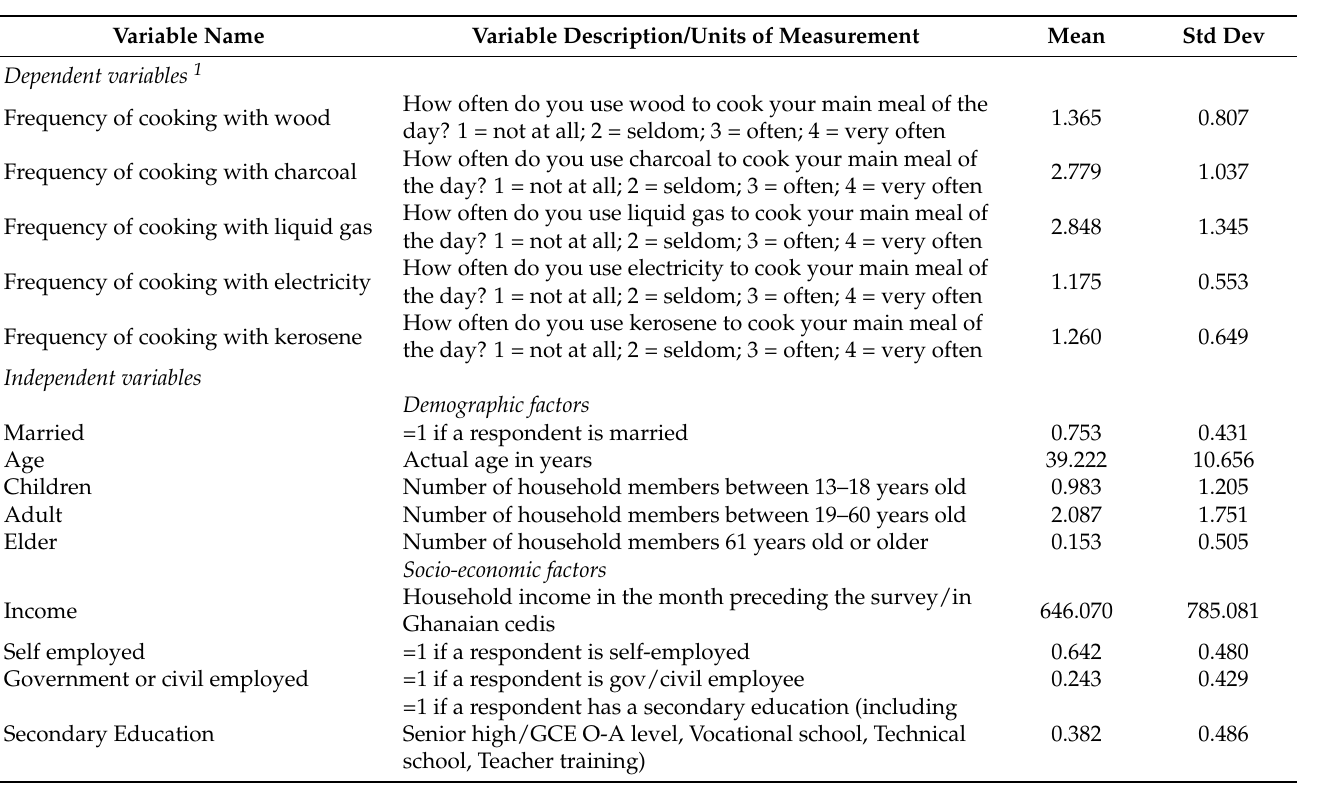
Figure 1. The use of five fuels in cooking the main meal of the day by four frequency categories in urban households in Ghana, in% ( n = 956). Source: Summary responses from the household survey. Table 1. Descriptive statistics of variables included in the empirical model.